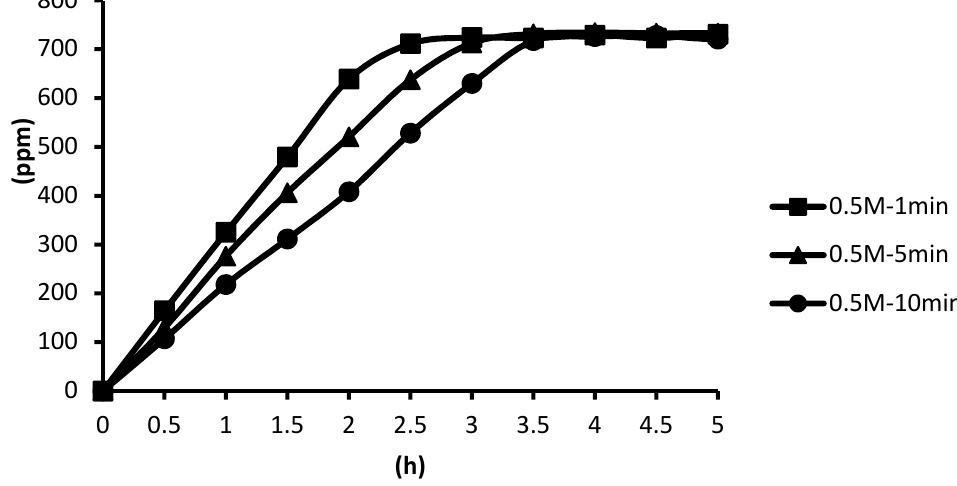
Figure 13. The effect of cross-linking time by 0.5 M CaCl 2 on releasing of tea tree essential oil from alginate/tea tree essential oil microcapsules in the hot spring